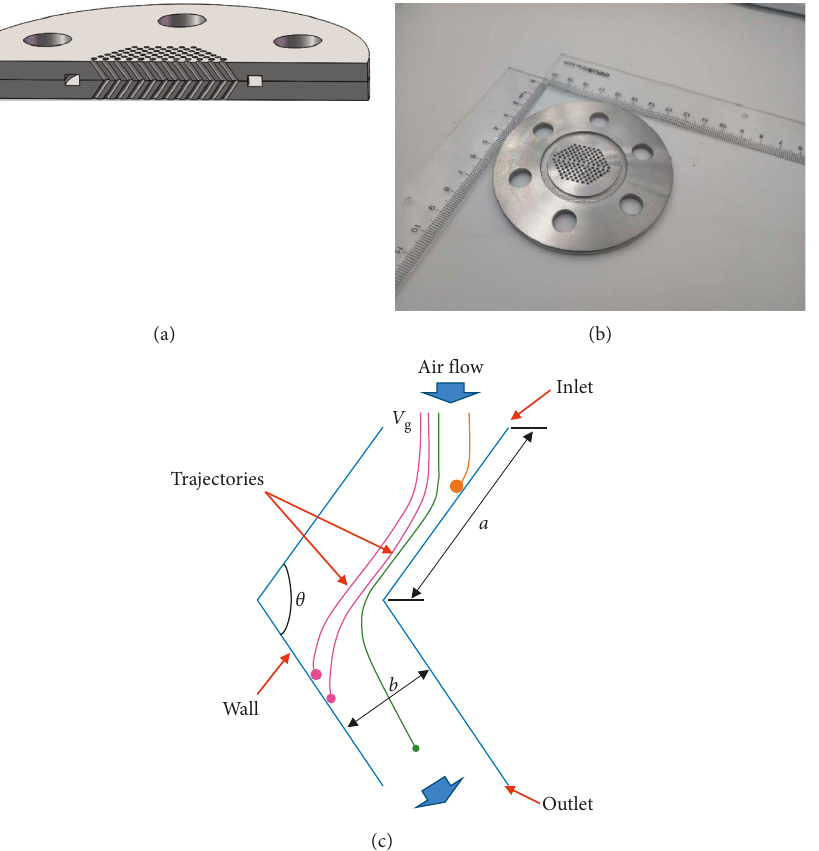
Figure 2: Inertial impactor model. (a) The cross-sectional structure of an experimental sample containing 126 mesoscopic impactors. (b) Photograph of the experimental sample fabricated in stainless steel. (c) Conceptual illustrations of the basic building block of the mesoscopic impactor.